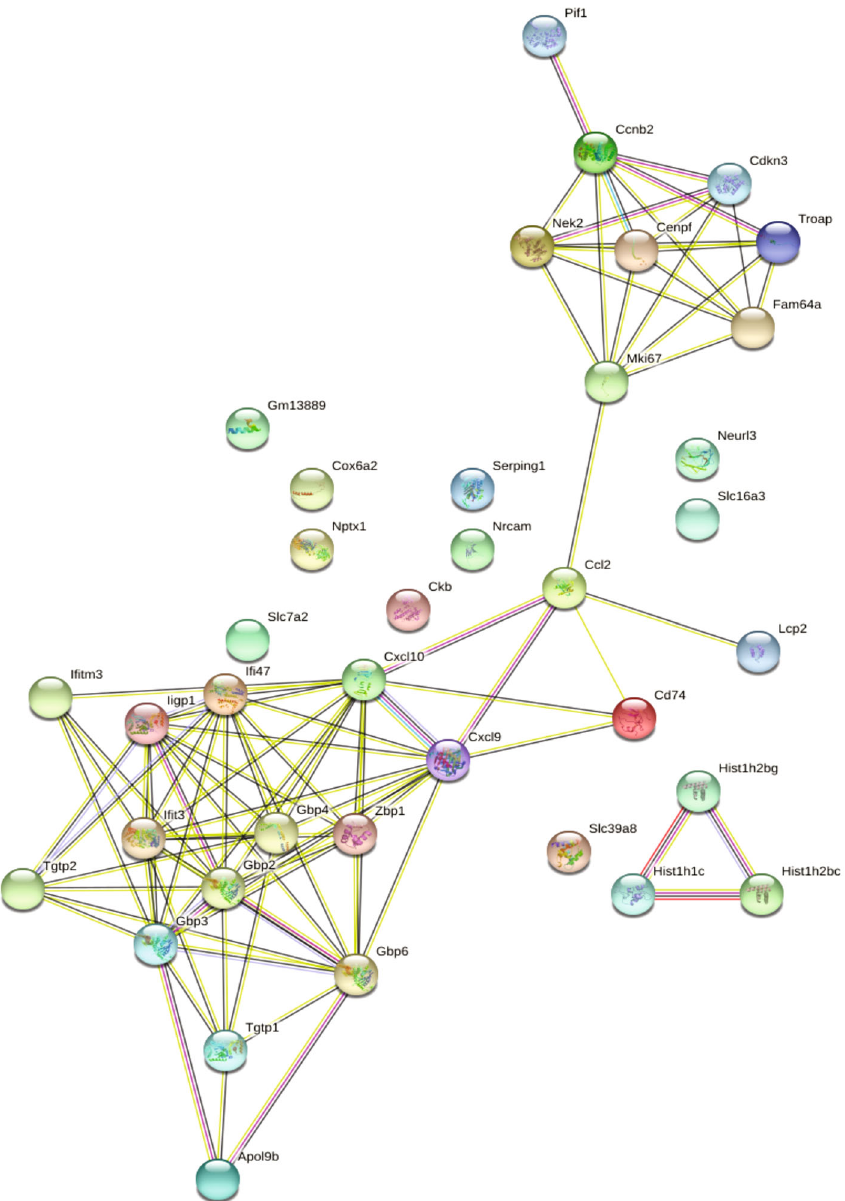
Figure 4: Protein-protein interaction network analysis of top 20 upregulated and 20 downregulated mRNAs was performed by using online tool String (https://www.string-db.org/). The di ff erent circles represent di ff erent protein-coding